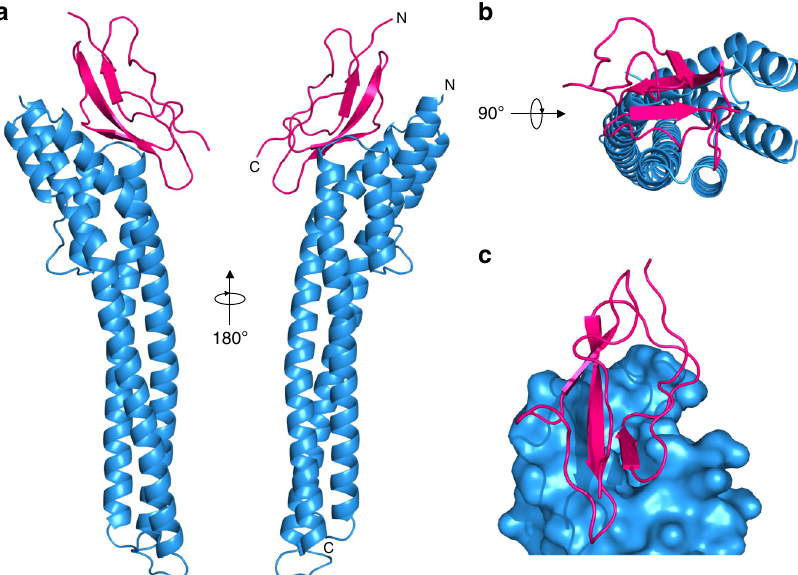
Fig. 3 The structure of FHR bound to FH domain 5. a Two views of FHR (blue) bound to FH domain 5 (pink). The N and C termini of FHR and domain 5 are indicated. The C terminus of FHR is plasma membrane proximal. b View of FHR (blue) bound to FH domain 5 (pink) viewed from the membrane-distal end. c Surface representation of the FH-binding pocket in FHR (blue) with the FH domain 5 (pink).